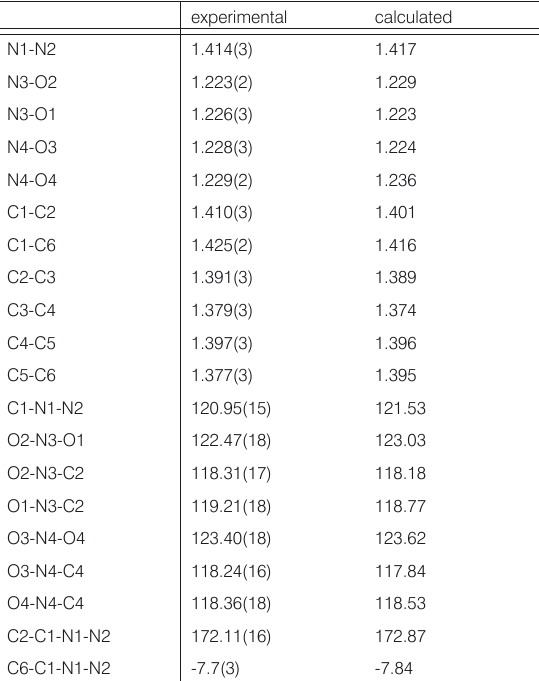
Table 2. Selected bond lengths [Å] and interbond angles [°] of